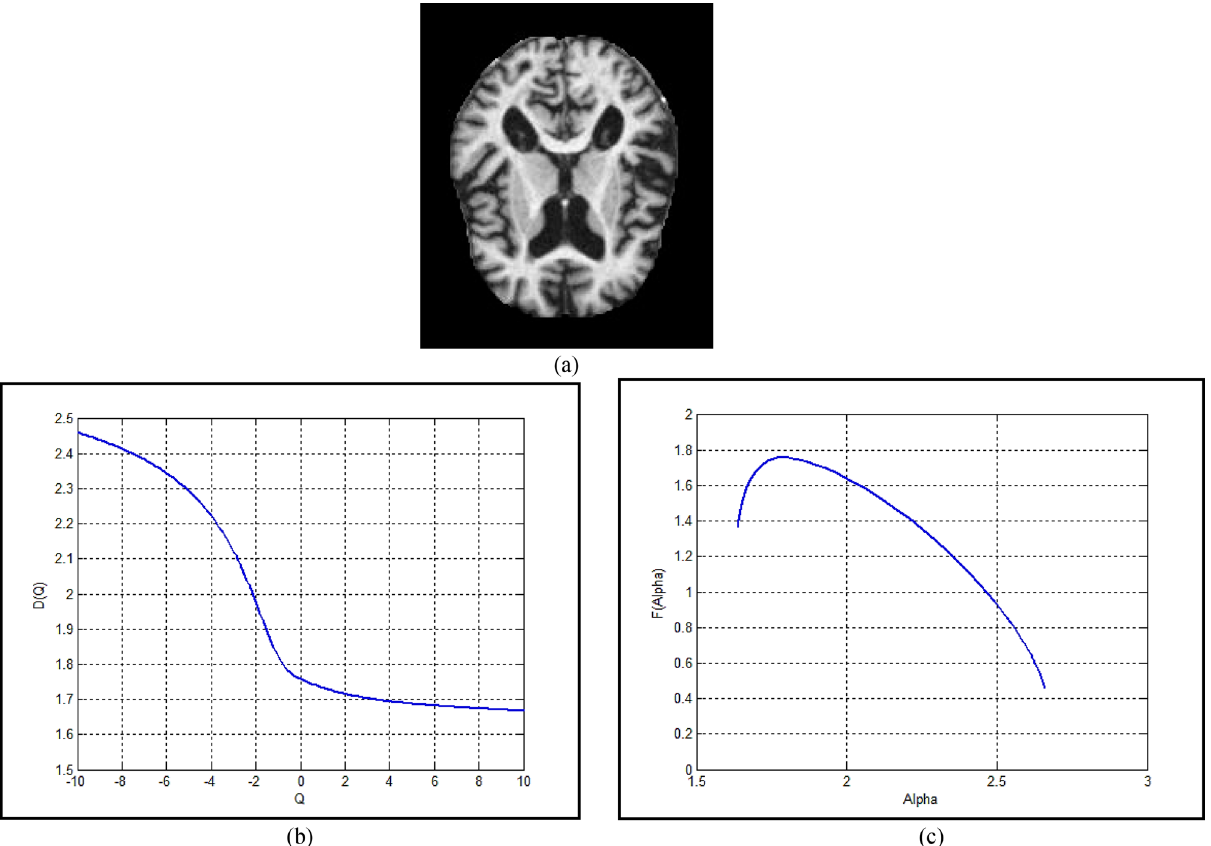
Figure 7. The brain sample image ( a ) the source image ( b ) the generalized dimension curve ( c ) the singularity spectrum.